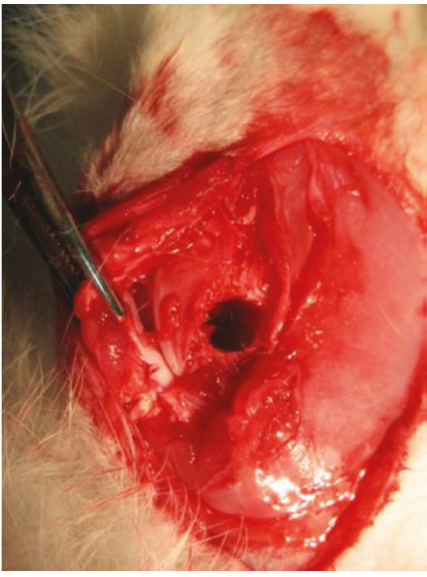
Figure 1: Critical size femoral defect of 6 mm of diameter in a rabbit